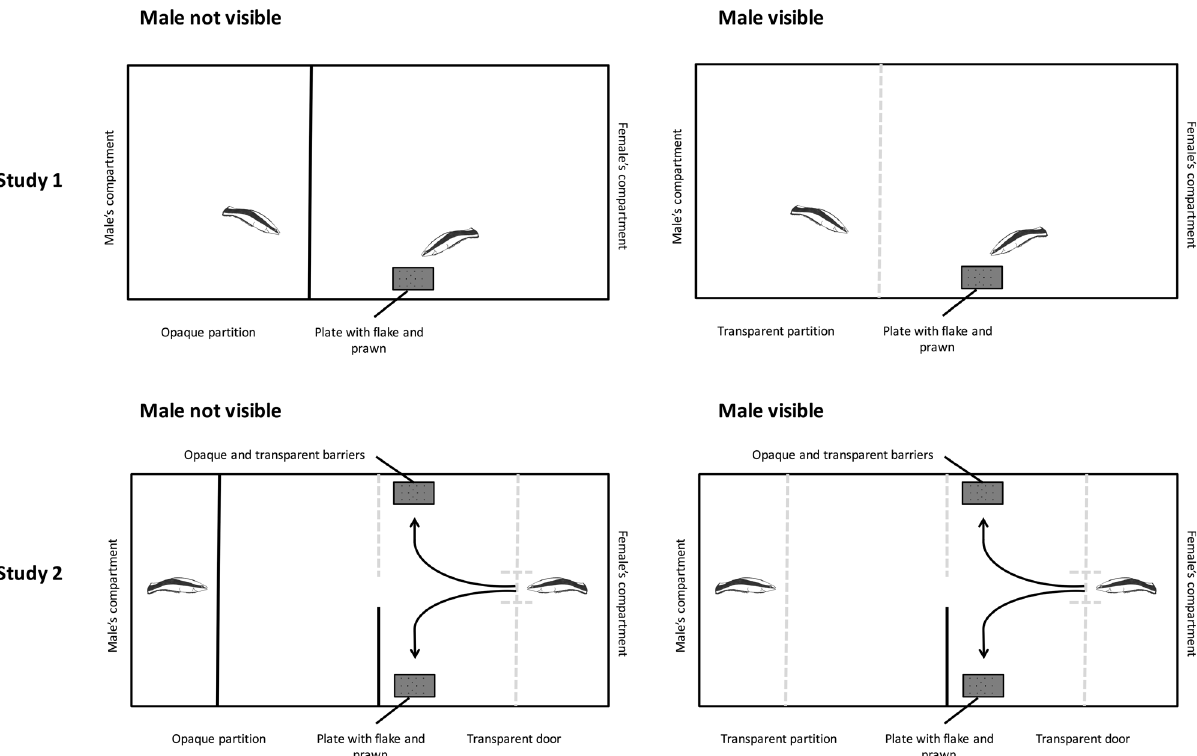
Fig. 1 Diagram of experimental set up for Studies 1 and 2. Diagram of the experimental set up for Study 1 and 2. In Study 1, females and males were separated by either an opaque (male not visible condition) or transparent partition (male visible condition). The female was presented with a plate with 12 fl ake and 2 prawn items. The plate was removed when she ate a prawn item and the male was released from his compartment and punishment was monitored. In Study 2, males were again separated by either an opaque or transparent partition. The female began each trial behind a transparent partition with a small door at its center. Plates with 12 fl ake and 2 prawn items were presented behind an opaque and transparent barrier. When the plates were in place, the door was lifted and the female swam through the center of the choice arena. The female then chose to eat at the plate behind one of the barriers and the other plate was removed. The chosen plate was removed when she ate a prawn and the male was released from his compartment and punishment was monitored.